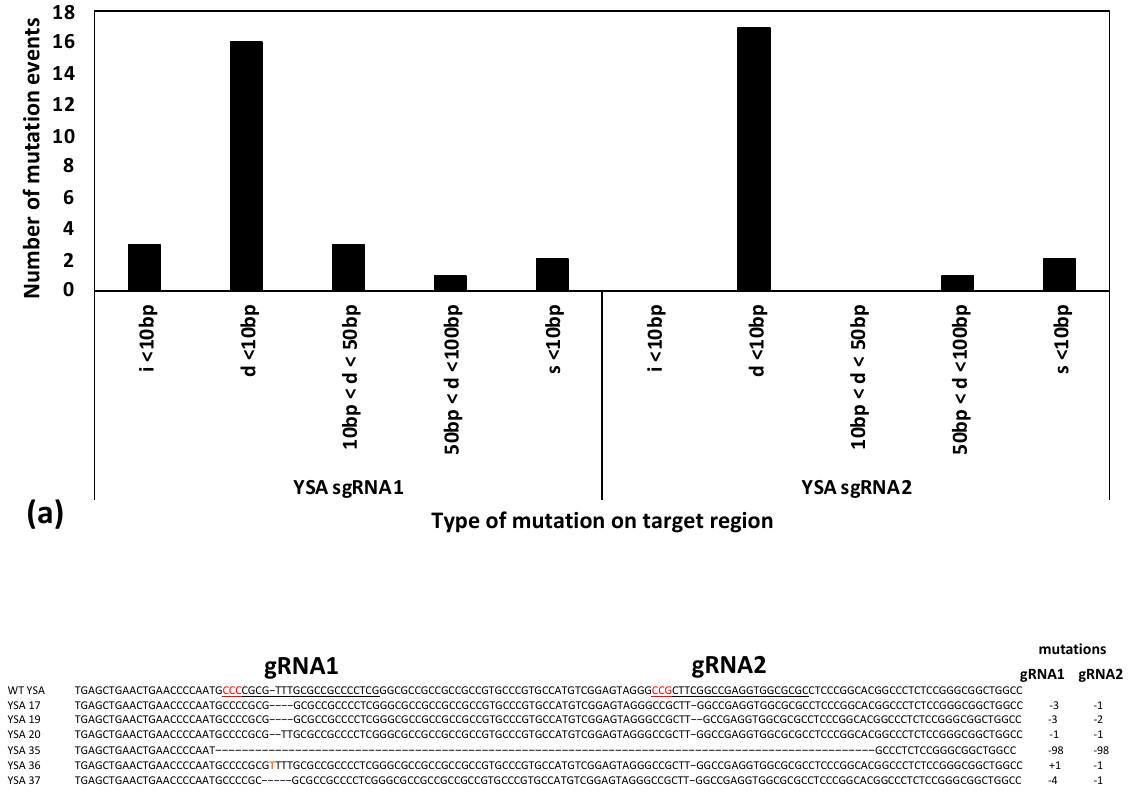
Figure 4. ( a ) Histogram showing the number of different mutation types, including insertions (i), deletions (d), and base substitutions (s), for the YSA target site; and ( b ) mutations detected at the YSA target site for gRNA1 and gRNA2, which are 40 base pairs apart. The wild type (WT) YSA sequence is shown at top, with the two gRNAs underlined and the PAM sites underlined and in red, followed by representative samples with differing mutations. The type of mutation is shows as the number of base pairs inserted (+) or deleted (-), followed by the number of alleles with the same mutation detected across the edited progeny. One allele showed a 98 bp deletion spanning gRNA1 and gRNA2. A single base insertion is shown in red at the gRNA1 site.